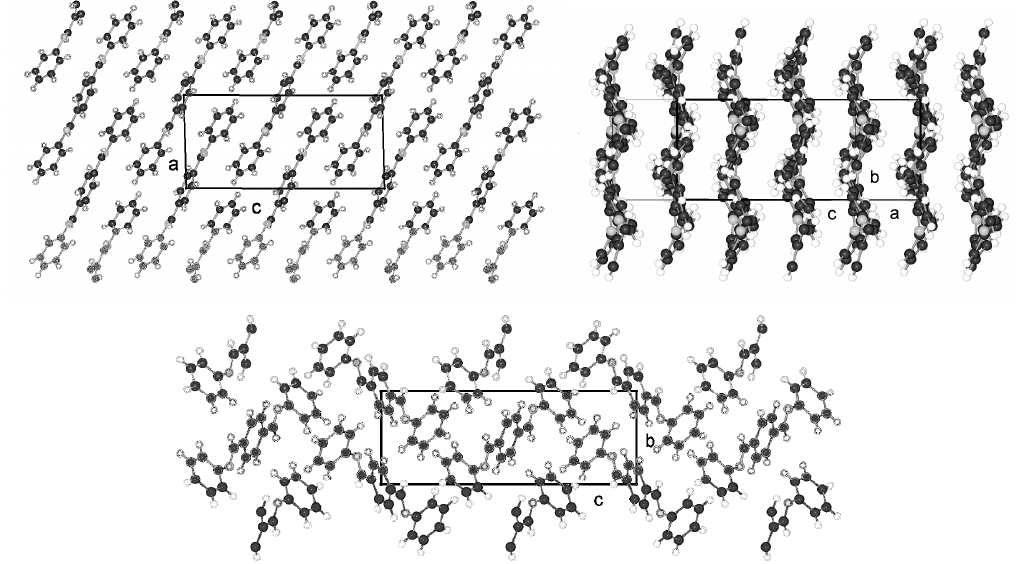
of the molecular